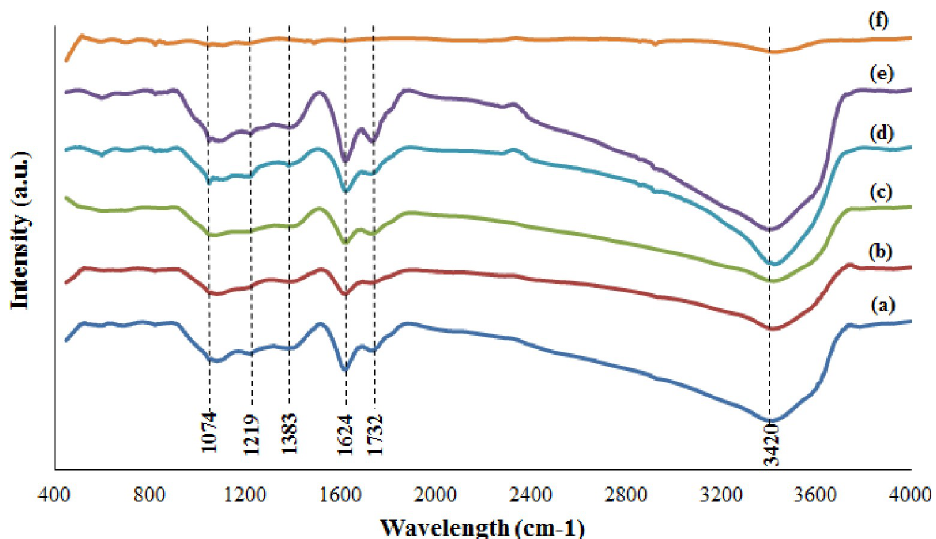
Fig 5. FTIR spectra of (a) GO20, (b) GO40, (c) GO60, (d) GO72, (e) GO80, and (f) graphite. https://doi.org/10.1371/journal.pone.0228322.g005 curve ~40–86 O ). For the first minor semicircle, the high-frequency region affected by charge transfer/photoexcited electrons is processed at the photoanode part. The next semicircle (mid- dle-frequency region) is attributed to the TiO /N-719 dye/KI electrolyte/Pt counter electrode 2 or GO72–TiO /N-719 dye/KI electrolyte/Pt counter electrode interface. The full range fre- 2 quency of semicircles for DSSCs was fitted into the equivalent circuit shown in the inset of Fig 8. The equivalent circuit was divided into three parts, and the entire elements were series resis- tance ( R ), which is represented as the first part (FTO/KI electrolyte), followed by the parallel s